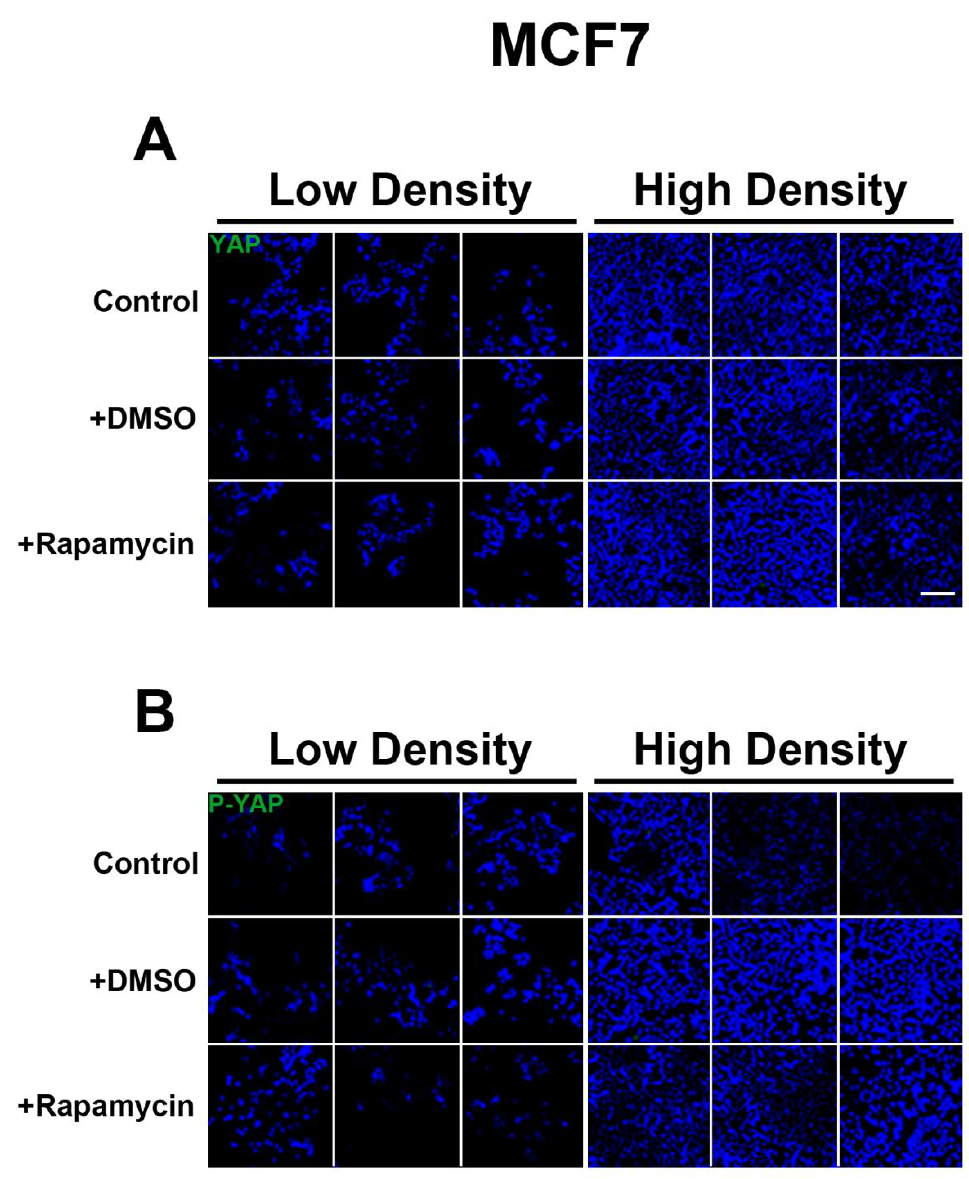
Figure S1. YAP is not expressed in MCF7 cells. (A-B) Immunofluorescent staining of YAP(A, green) and P-YAP (B, green) in MCF7 cells with and without rapamycin treatment at low and high cell density conditions. TOPRO3 (blue) labels nuclei. Scale bars,